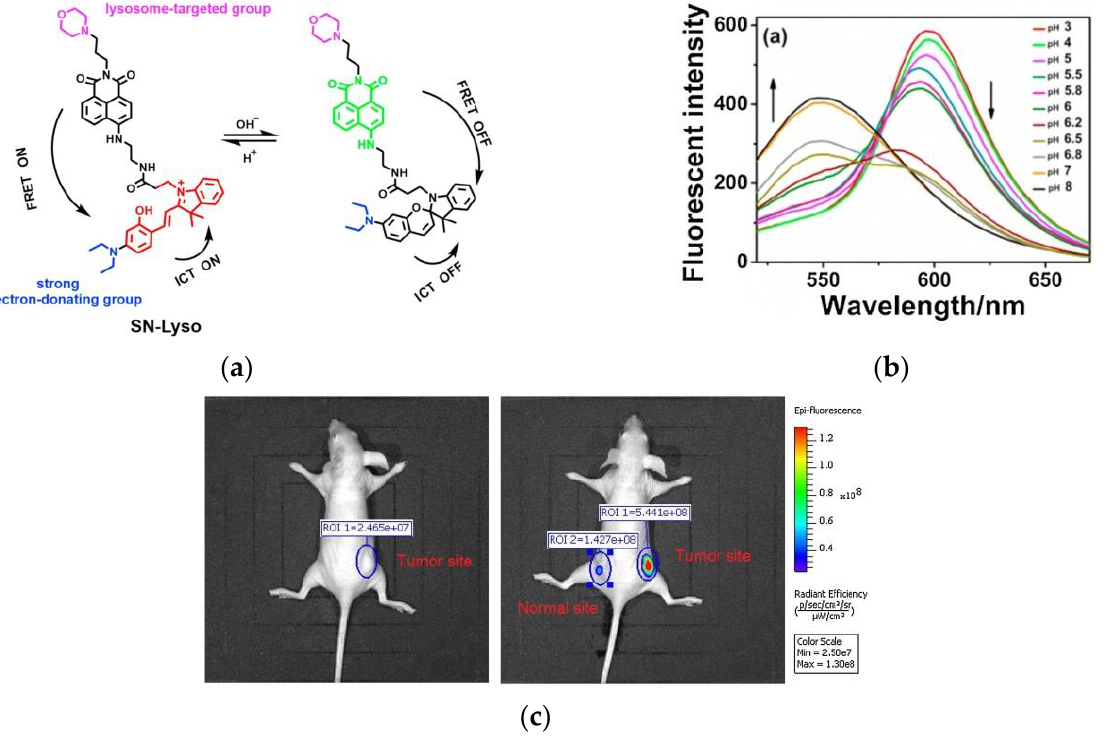
Figure 16. ( a ) Response mechanism of SN-Lyso for pH detection; ( b ) Fluorescence spectra of SN-Lyso at different pH values; (c ) Fluorescence imaging of the tumor and the normal site in HeLa tumor-bearing nude mice. Reproduced with permission from [77]. Copyright 2021 Elsevier B.V.